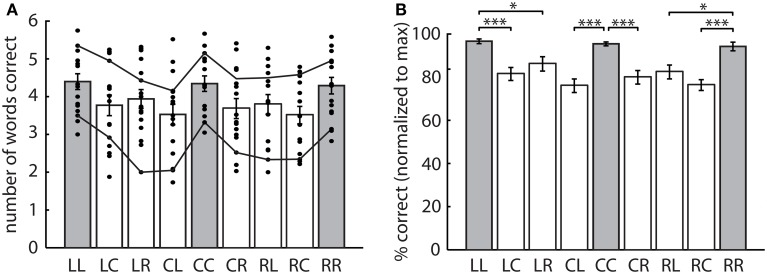
Experiment 1 scores. (A) Mean number of words correct for nine spatial conditions. Large variability in individuals scores (dots) was observed but trends across conditions were similar between high and low performing subjects (solid lines). (B) Normalized percentage correct for nine spatial conditions. Performance was significantly higher for no switch (gray) compared to switch trials (white). Bars represent mean ± SEM, *p < 0.05, ***p < 0.001.